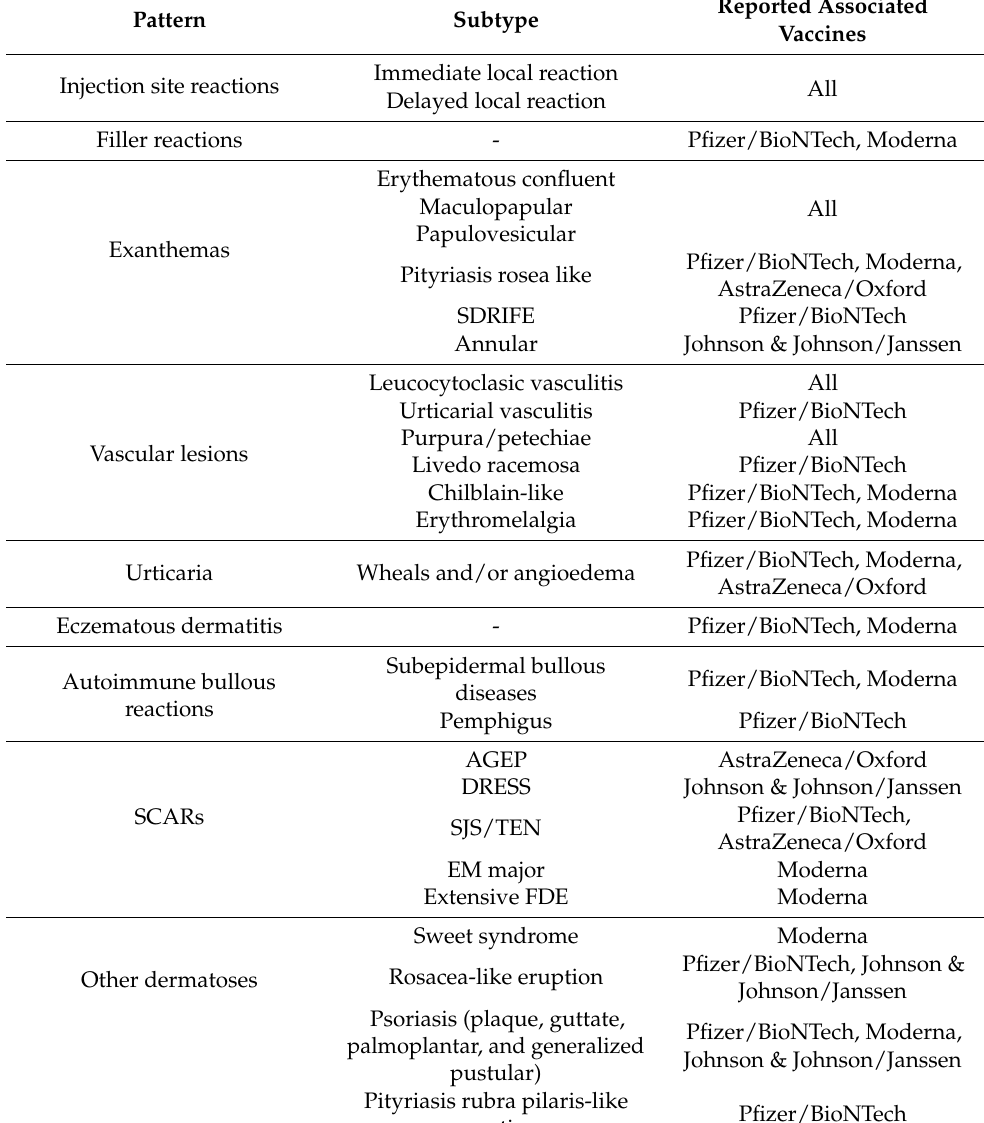
Table 1. Patterns of new onset adverse skin reactions associated with SARS-CoV-2